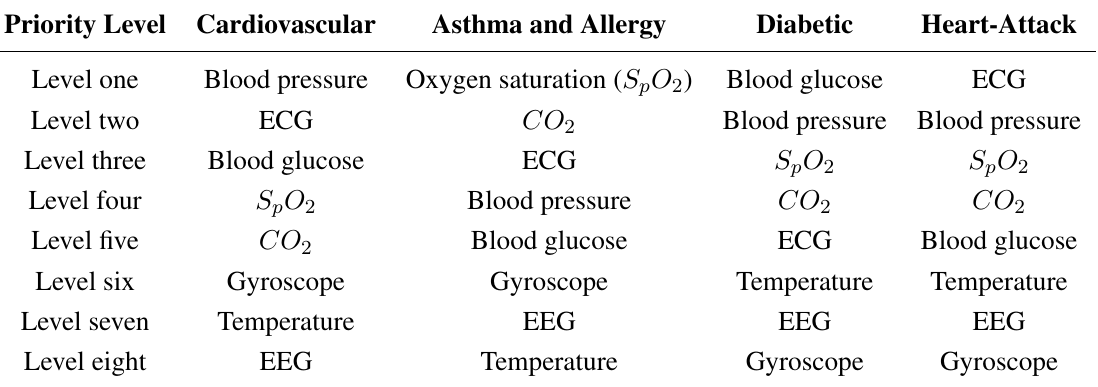
Table 2. Importance level of physiological signals in some medical applications.